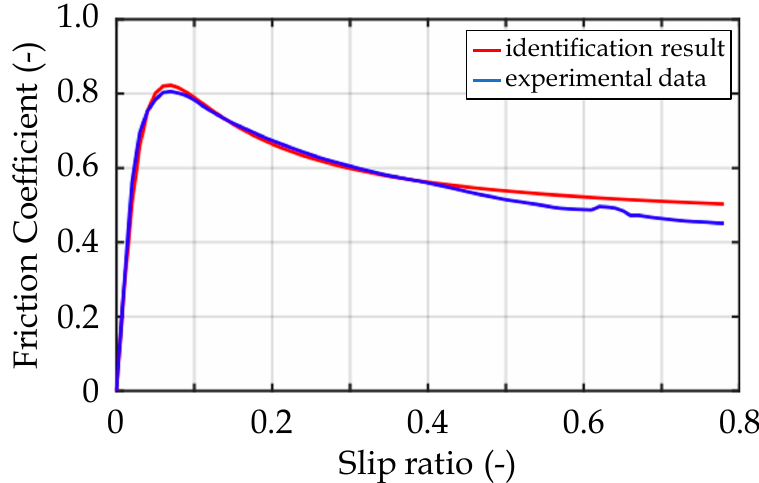
Figure 10. Comparison between the experiment and identification results [4].